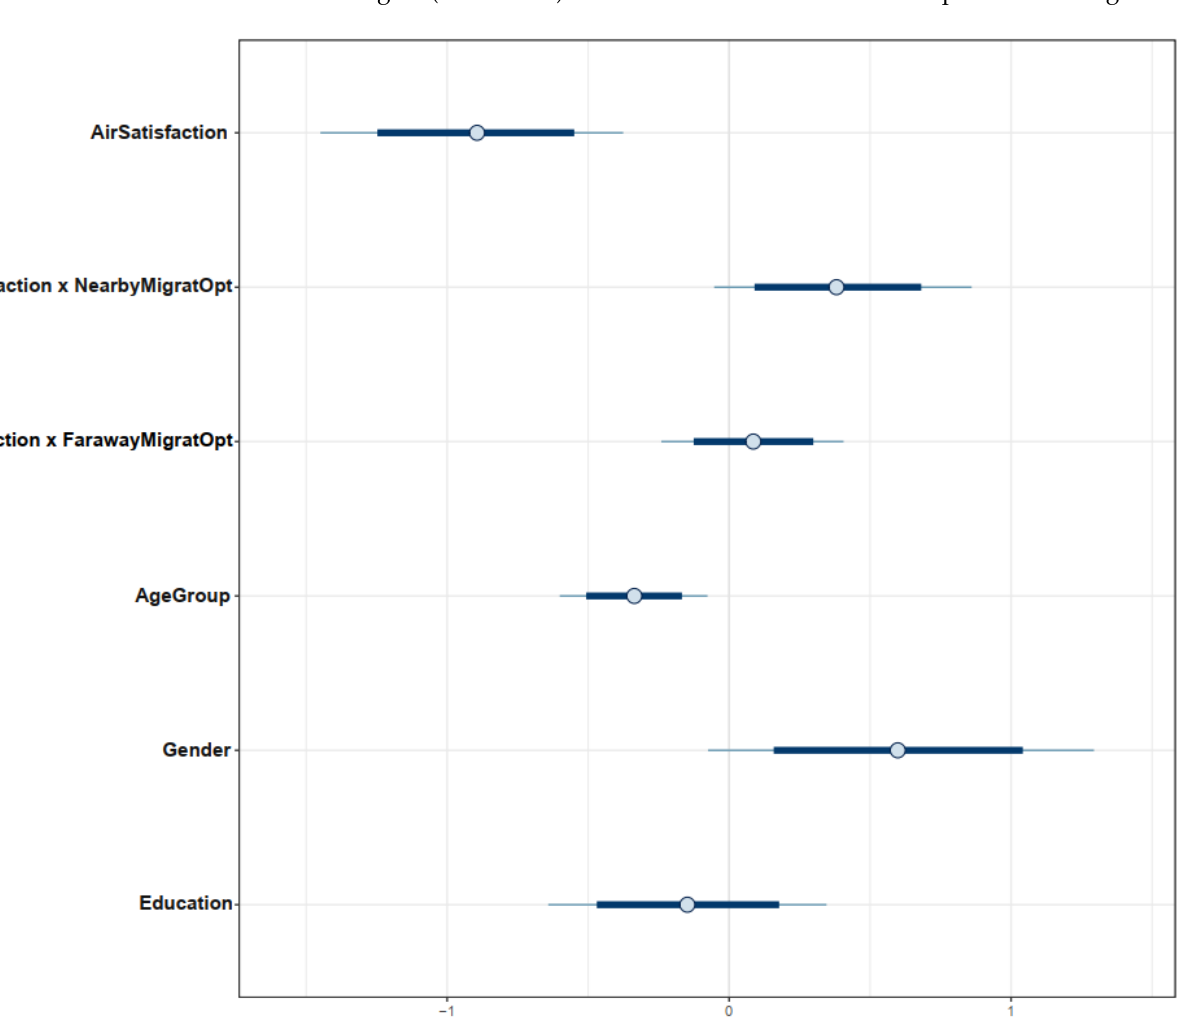
Figure 8. Distributions of Model 2 ′ s posterior coefficients on an interval plot.